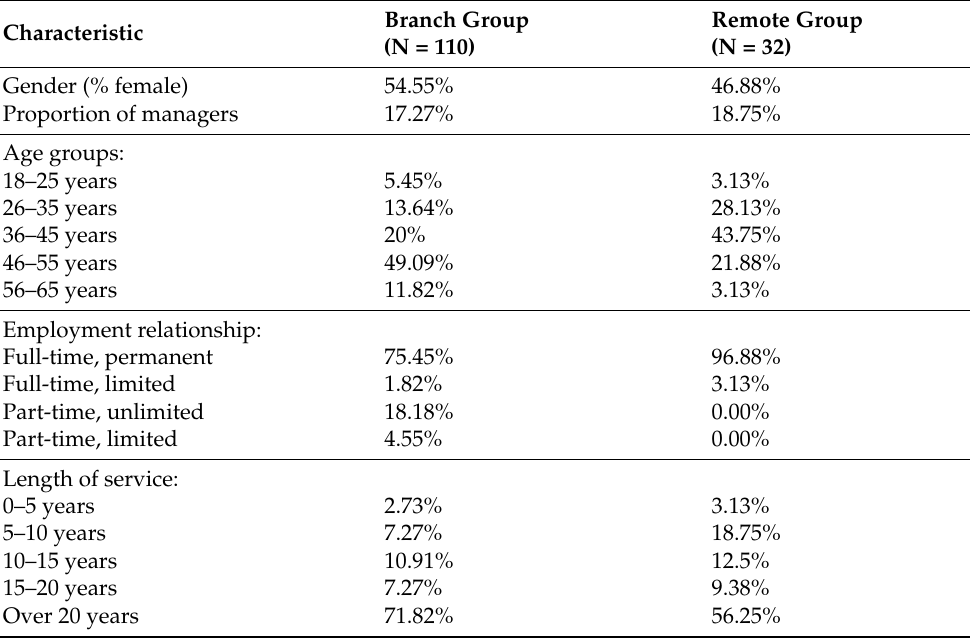
Table 3. Distribution of sample characteristics in the remote and branch groups in